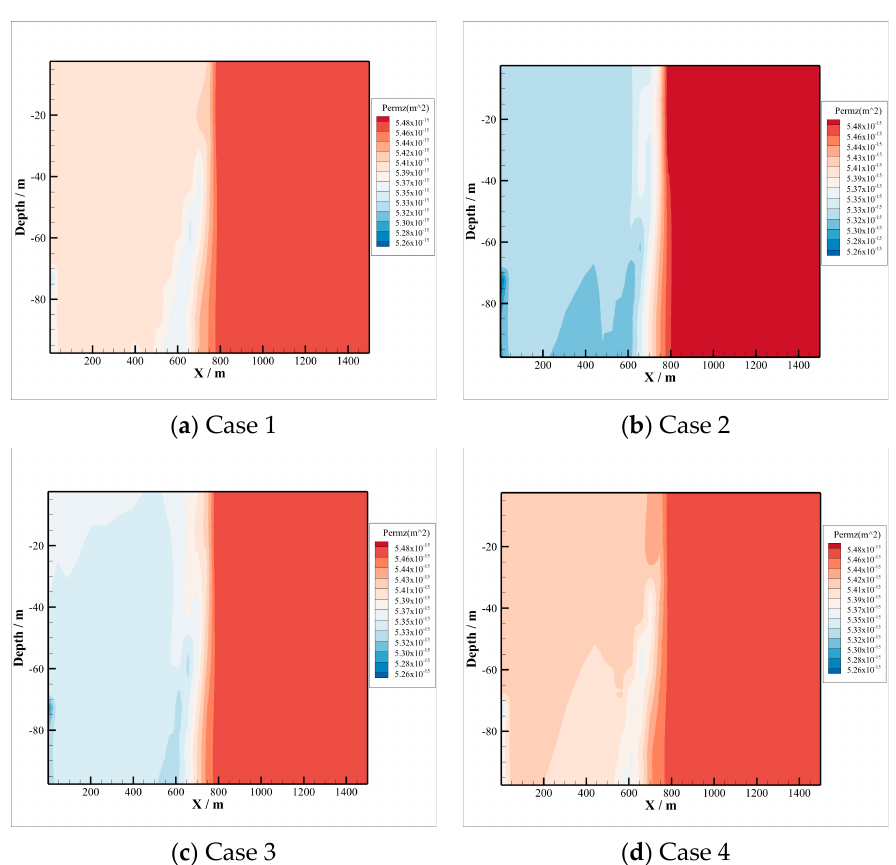
Figure 21. Permeability variations in different cases.